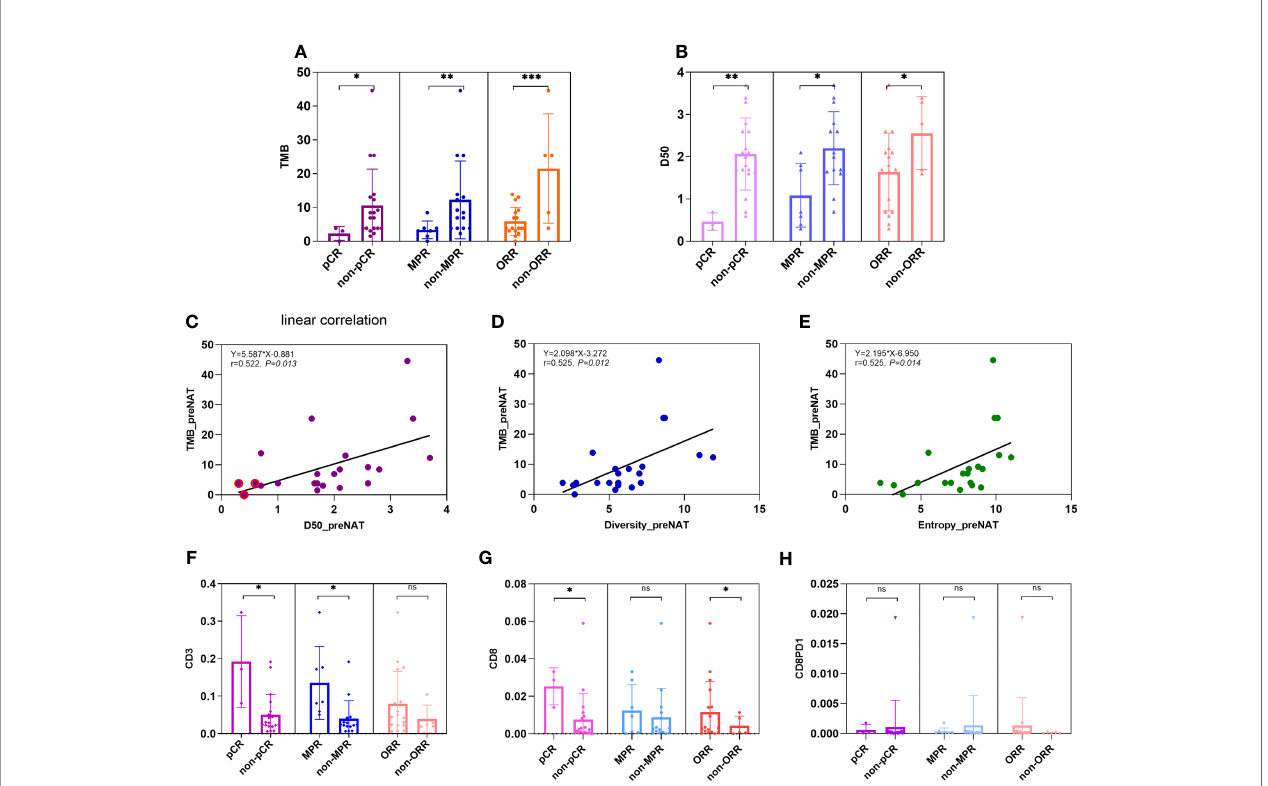
FIGURE 1 | Comparison of TMB, TCR D50, and percentages of CD3 + , CD8 + , and PD1 + CD8 + T cells in pre-NAC tumors between groups of pCR versus non-pCR. (A) Average TMB is higher in tumors of non-pCR patients than in pCR patients (10.6 vs. 2.3; p = 0.043), higher in tumors of non-MPR than MPR patients (12.3 vs. 3.4, p = 0.007), and higher in tumors of non-ORR than ORR patients (21.5 vs. 5.7, p = 0.001). (B) Average TCR D50 is higher in tumors of non-pCR patients than in pCR patients (2.07 vs. 0.47; p = 0.010), higher in tumors of non-MPR than MPR patients (2.20 vs. 1.08, p = 0.018), and higher in tumors of non-ORR than ORR patients (2.56 vs. 1.64, p = 0.034). (C – E) Linear correlation was observed between TMB and metrics of TCR like D50 ( y = 5.587 x − 0.881; r = 0.522, p = 0.013), diversity index ( y = 2.098 x − 3.272; r = 0.525, p = 0.012), and entropy ( y = 2.195 x − 6.950; r = 0.525, p = 0.014). (F) The percentages of CD3 + cells were all higher in pCR versus non-pCR patients (14.35% vs. 5.87%, p = 0.050), in MPR vs. non-MPR patients (9.27% vs. 5.98%, p = 0.041), but not signi fi cantly different between ORR versus non-ORR patients (7.94% vs. 3.94%, 0.347). (G) The percentages of CD8 + cells were higher in pCR versus non-pCR patients (2.53% vs. 0.75%, p = 0.025), numerically but not statistically higher in MPR versus non-MPR patients (1.21% vs. 0.14%, p = 0.573), and in ORR versus non-ORR patients (1.16% vs. 0.41%, p = 0.034). (H) The percentages of CD8 + PD1 + cells were numerically but not statistically lower in pCR versus non-pCR patients (0.07% vs. 0.11%, p = 0.072), MPR versus non-MPR patients (0.03% vs. 0.21%, p = 0.858), and ORR versus non-ORR patients (0.13% vs. 0.007%, p = 0.229). ns, not signi fi cant; * p < 0.05; ** p < 0.01; *** p <